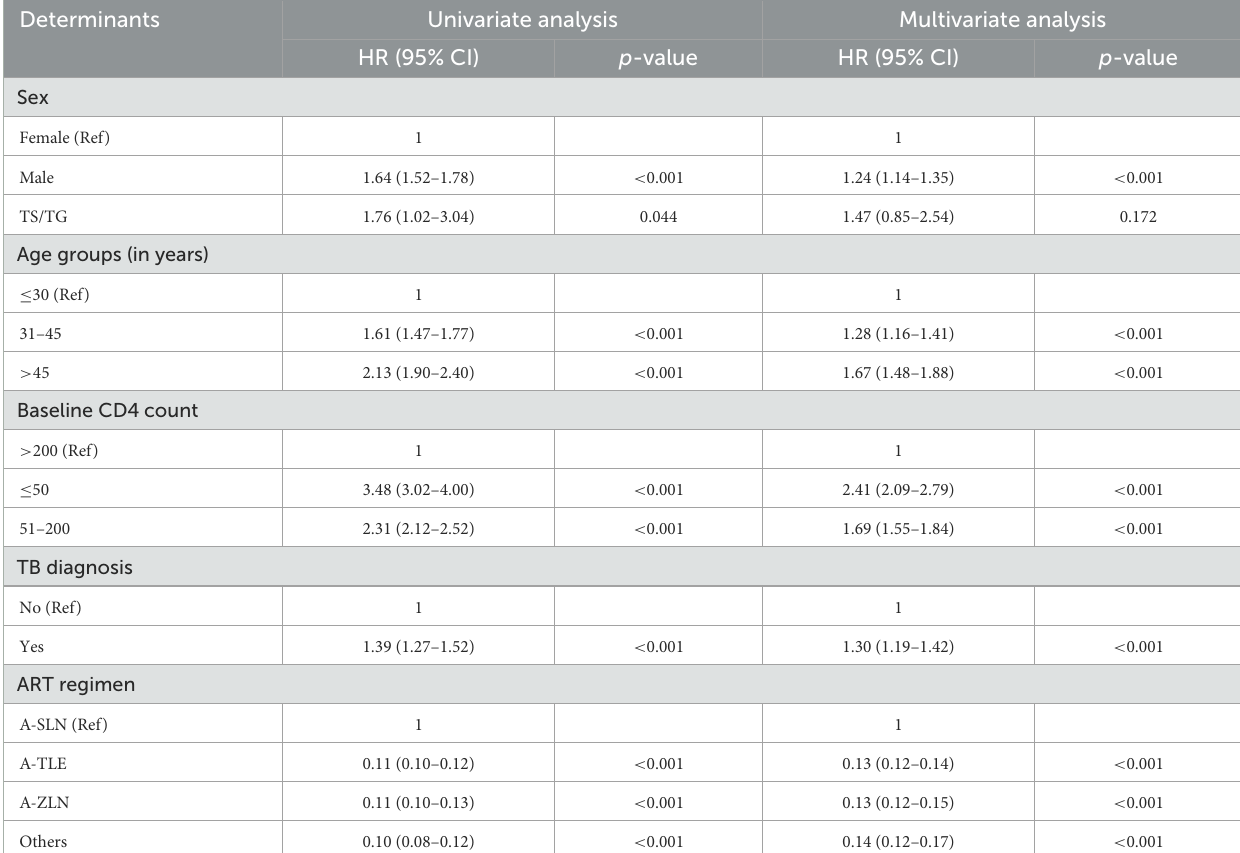
TABLE 3 Cox regression model to explore determinants of mortality [hazard ratio (HR) of mortality of patients on ART]. Determinants Univariate analysis Multivariate analysis